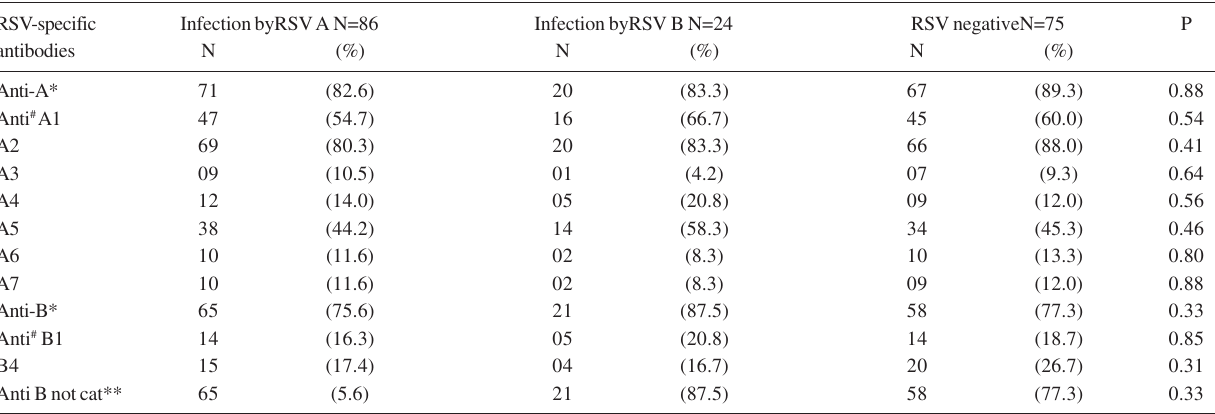
Table 2 - Prevalence of specific RSV antibodies: anti-A, anti-B and subtype-specific antibodies according to the viral status detected in the sera of infants with